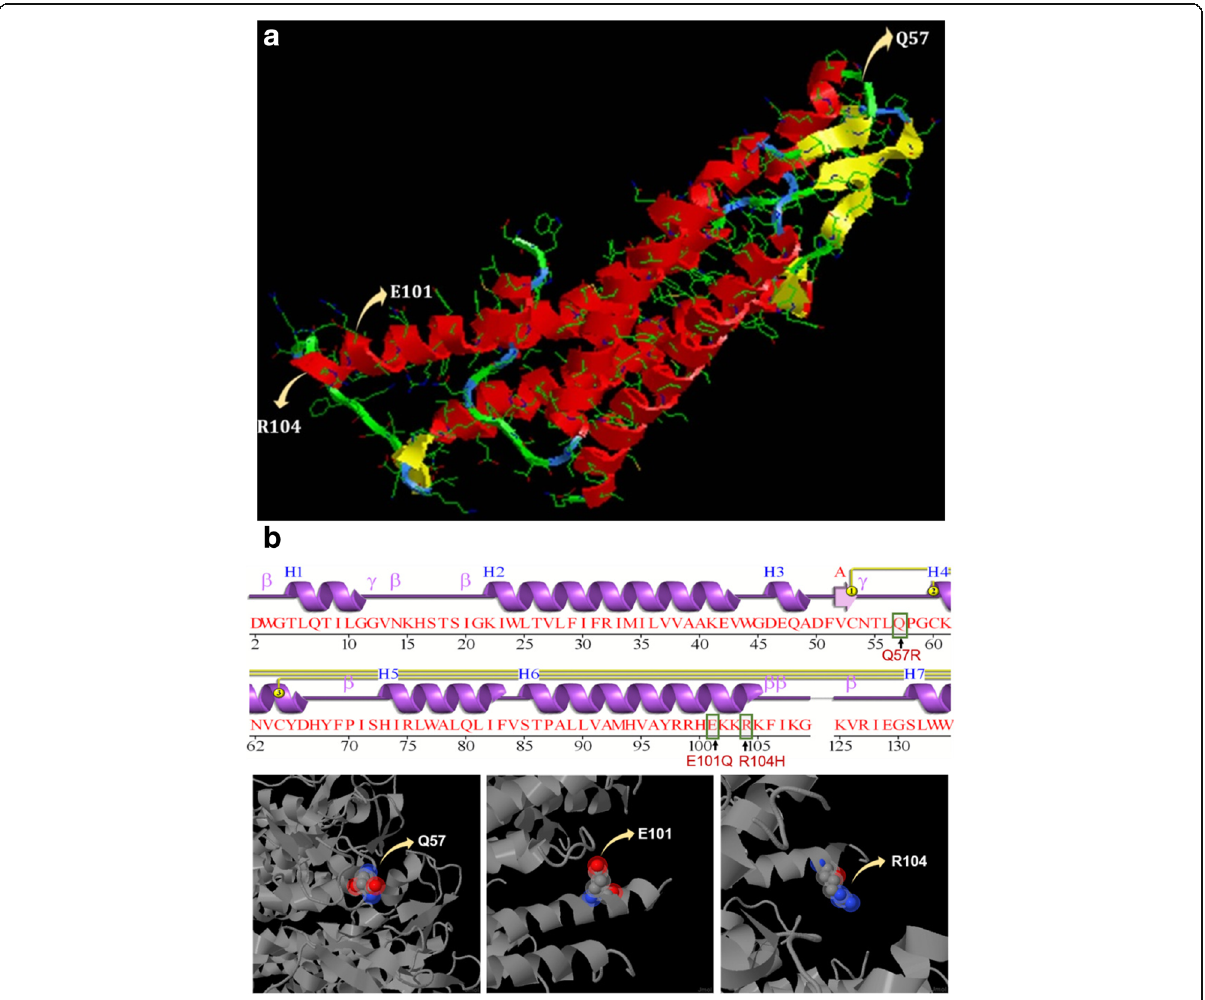
Fig. 7 a Predicted model of connexin 30 protein single chain indicating the positions of the variants, Q57, E101 & R104 observed in this study. b : Wiring diagram and 3-D structure of connexin 30 protein showing the position of Q57, E101 and